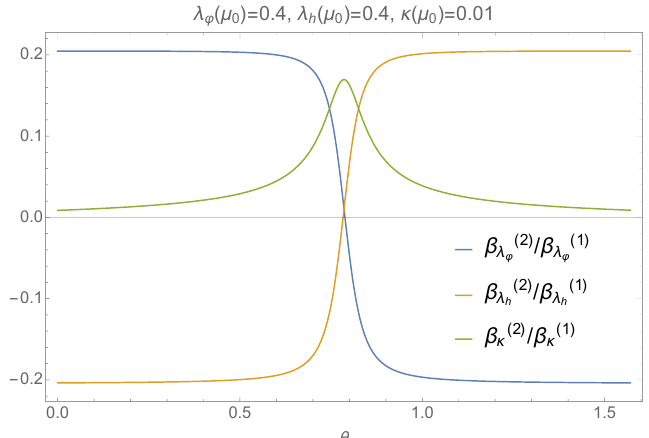
Figure 4 . The second terms in the beta functions eqs. (3.17){(3.19) are plotted as functions of (cid:18) . Here we normalize them by their (cid:12)rst terms respectively.